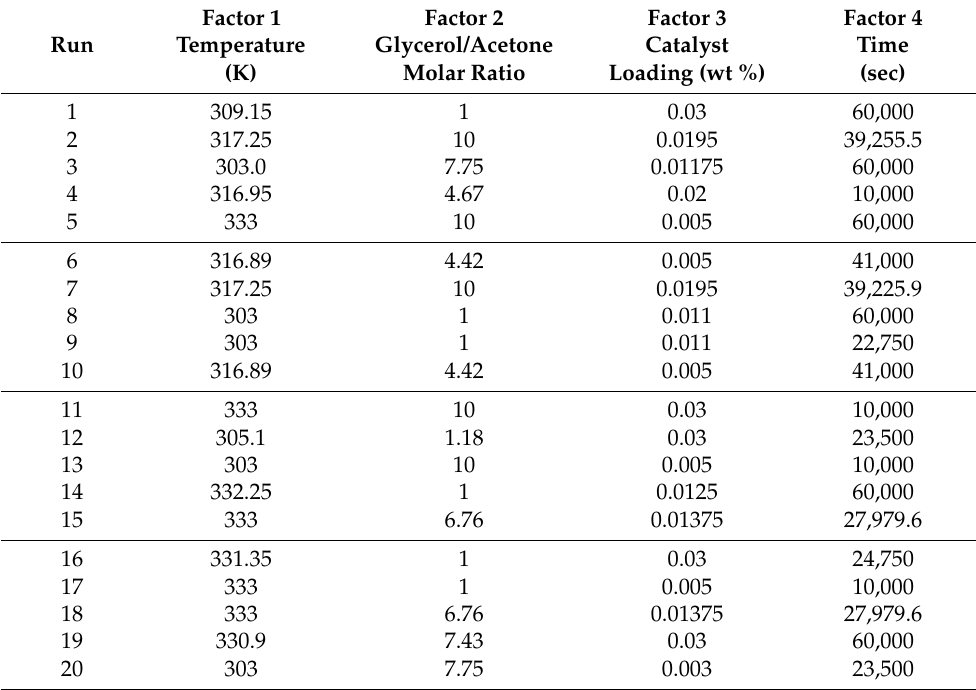
Table 4. Input parameter values for each simulation run using CCD